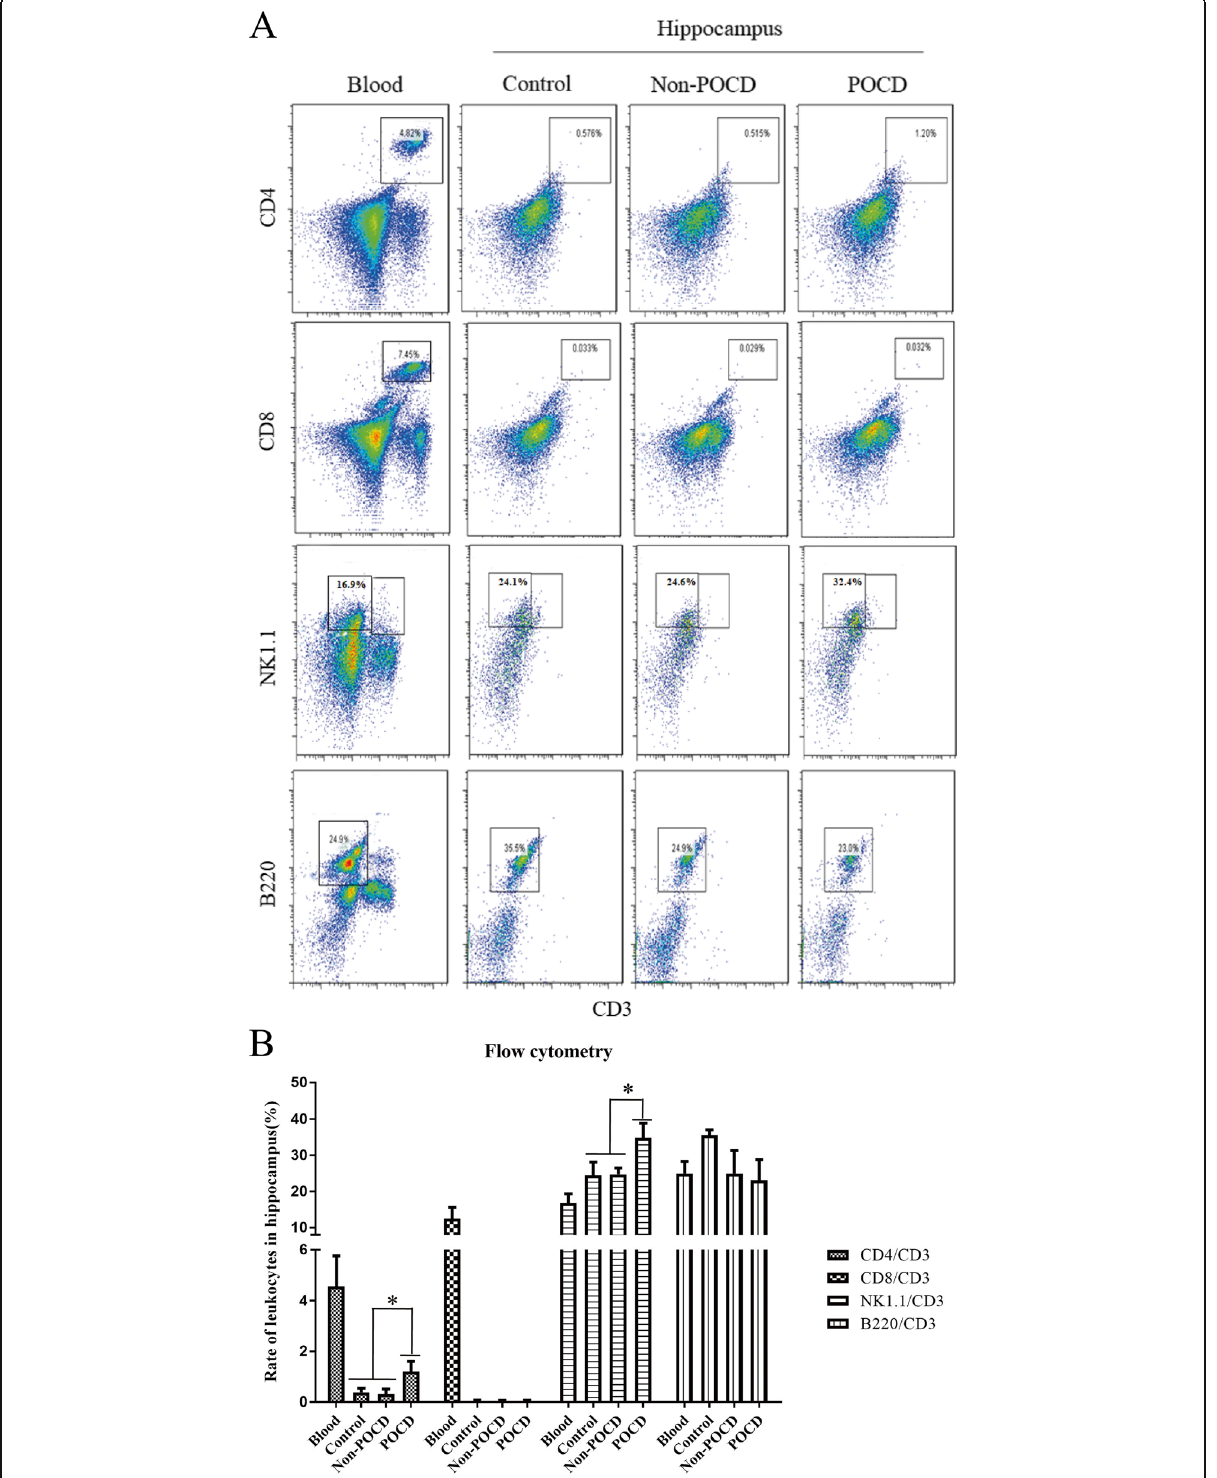
Fig. 3 Peripheral leukocytes in hippocampus of POCD calculated using flow cytometry. Flow cytometry sorting ( a ) and statistic analysis ( b ) of leukocytes in hippocampus. “ * ” represents statistical